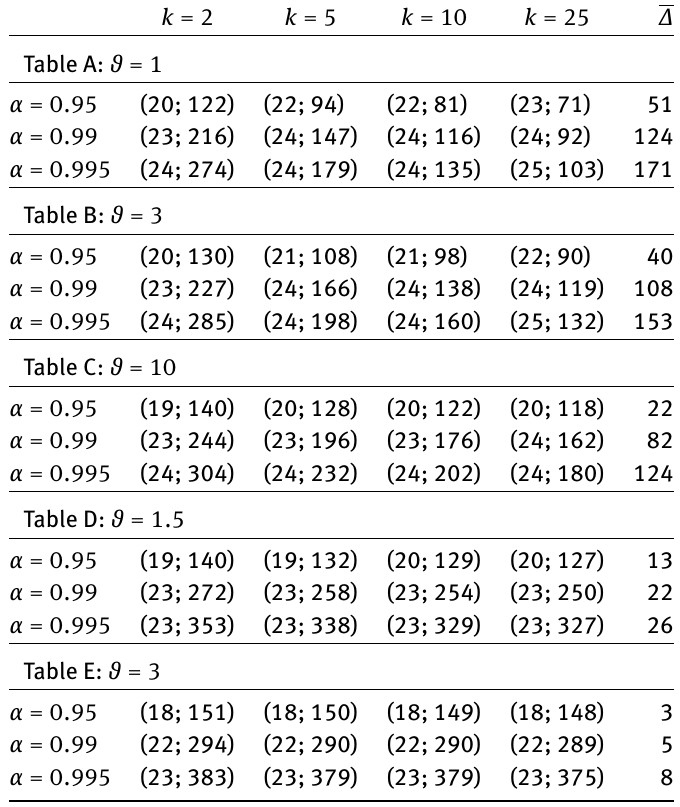
Table 5.4: VaR bounds in subgroup model with Clayton copula in A, B, and C and Gumbel copula in D and E.